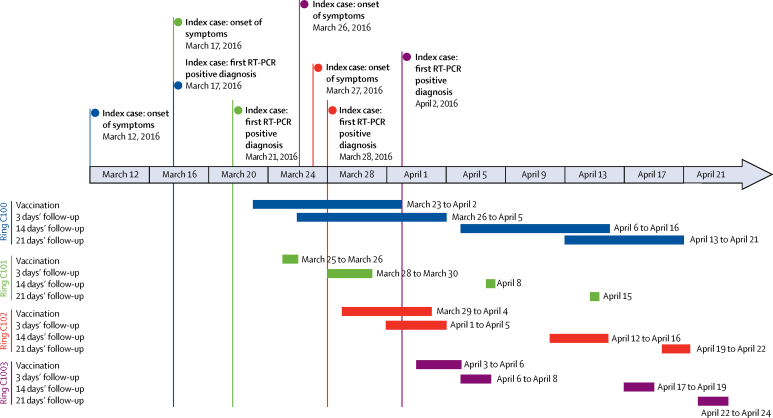
Timeline of operations in the four rings in Guinea